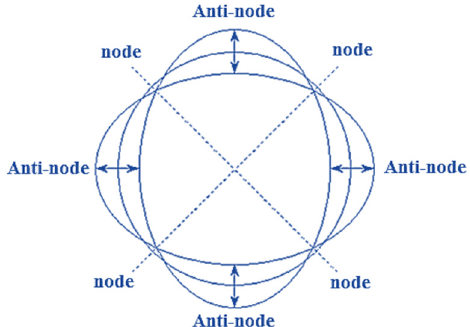
Figure 9. Gyroscope changing in nodes and anti-nodes in the second mode. Table 4. Material of electrodes, type of driving force and their dimensions. Table 4. Material of electrodes, type of driving force and their dimensions.